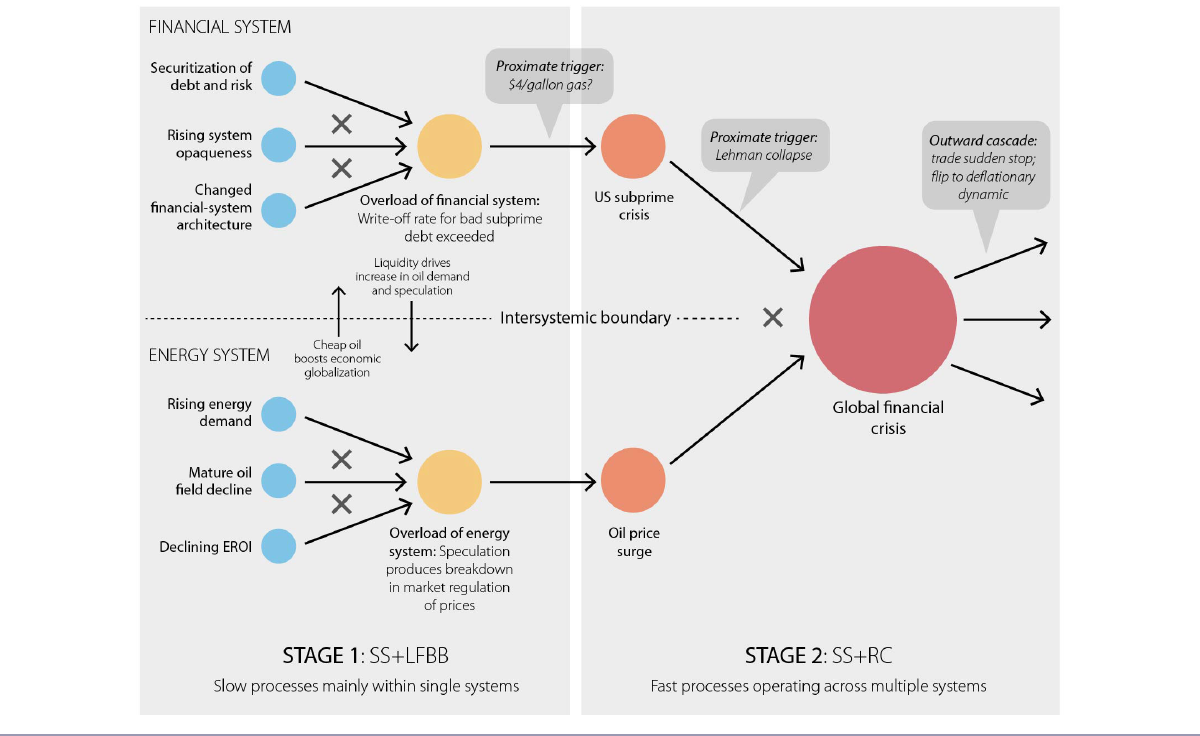
Fig. 2 . The 2008 financial-energy crisis. SS = simultaneous stresses; LFBB = long fuse big bang; RC = ramifying cascade; EROI = energy return on